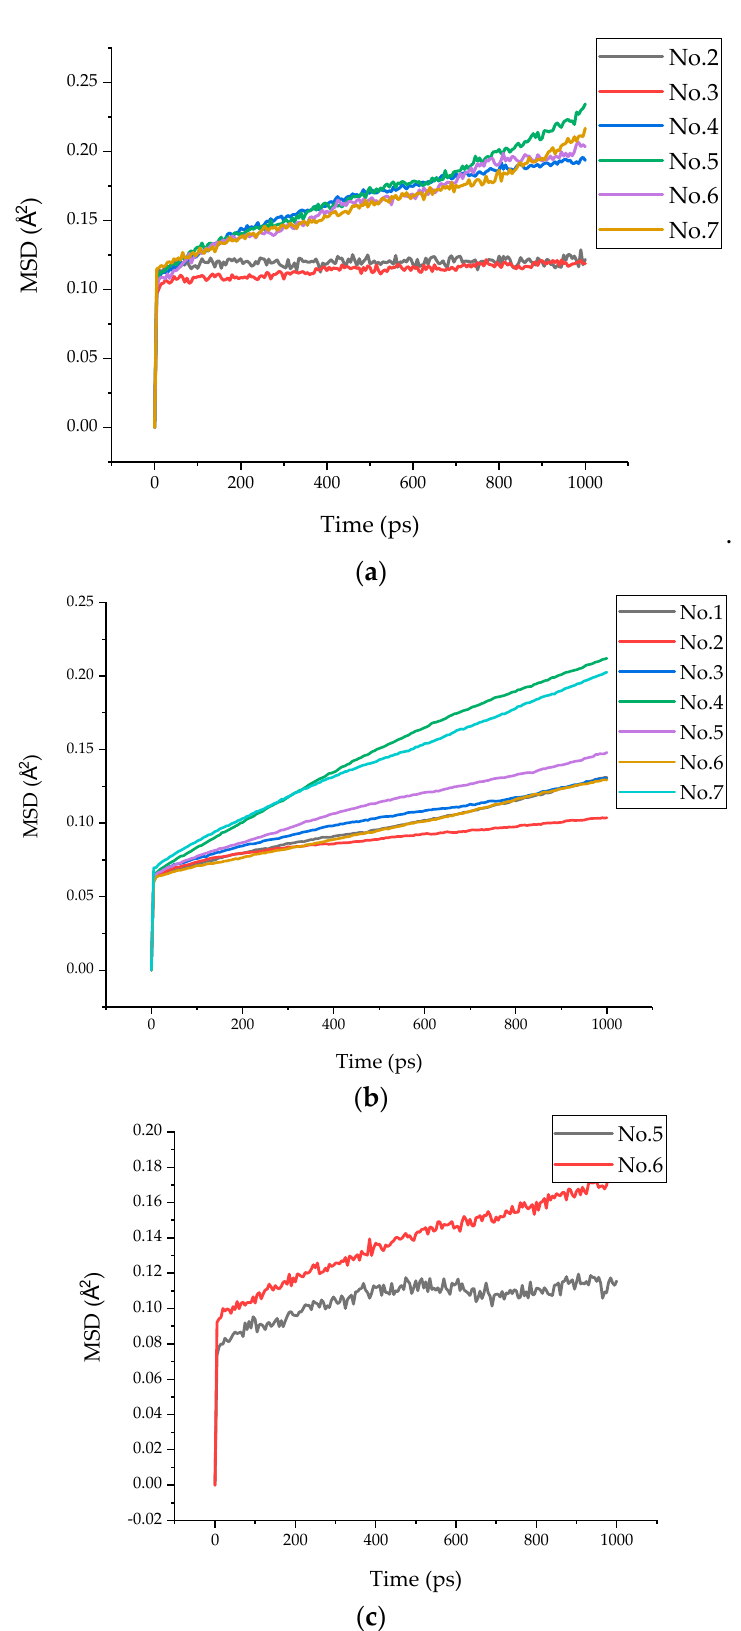
Figure 11. MSD of O, Si, and N atoms. ( a ) MSD of O atoms. ( b ) MSD of Si atoms. ( c ) MSD of N atoms.